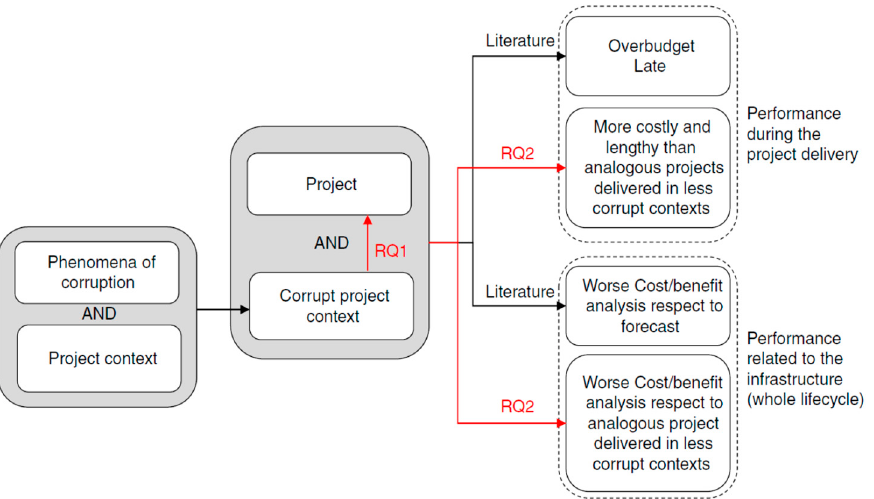
Figure 1. Presence of corruption in the PPPs. Source: Heydari et al. [7].